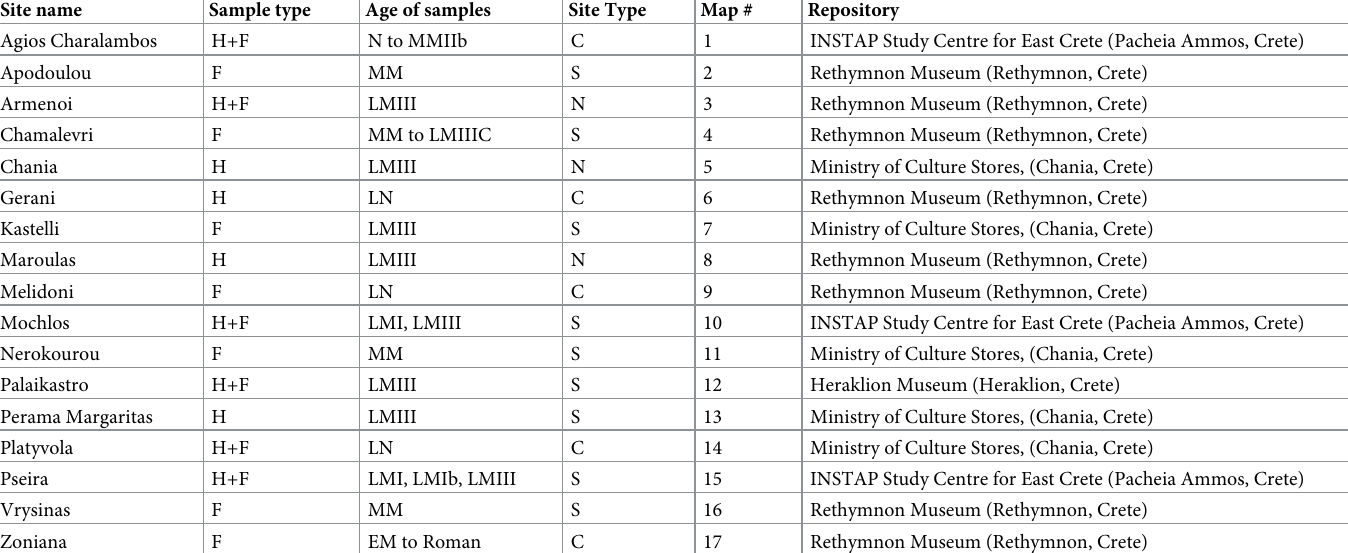
Table 1. List of study sites and ages of the samples used in this study. Sample Type: H = humans, F = fauna. Age of samples: N = Neolithic, LN = late Neolithic, EM = early Minoan, MM = middle Minoan, LM = late Minoan. Different chronological divisions of these phases are listed using roman numerals (e.g. I, II, III). Site type: C = cave site, N = Necropolis (cemetery), S = settlement. Map number refers to the site location in Fig 1.